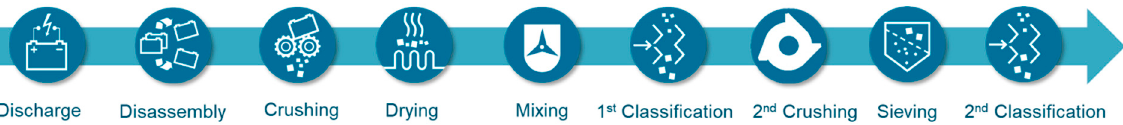
Figure 3. Developed process chain of mechanical/thermal processing of the LithoRec process prior to hydrometallurgical steps [20,28].